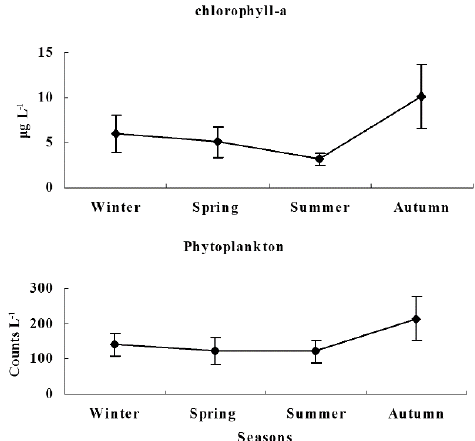
Figure 4. Seasonal periodicity of phytoplankton (mean values ±SD) along the main stream of the Nile in Upper Egypt during 2007.